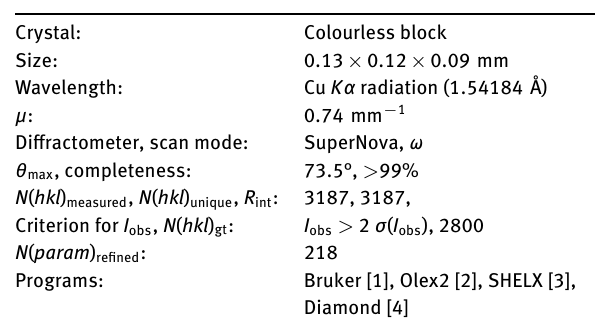
Table 1: Data collection and handling.